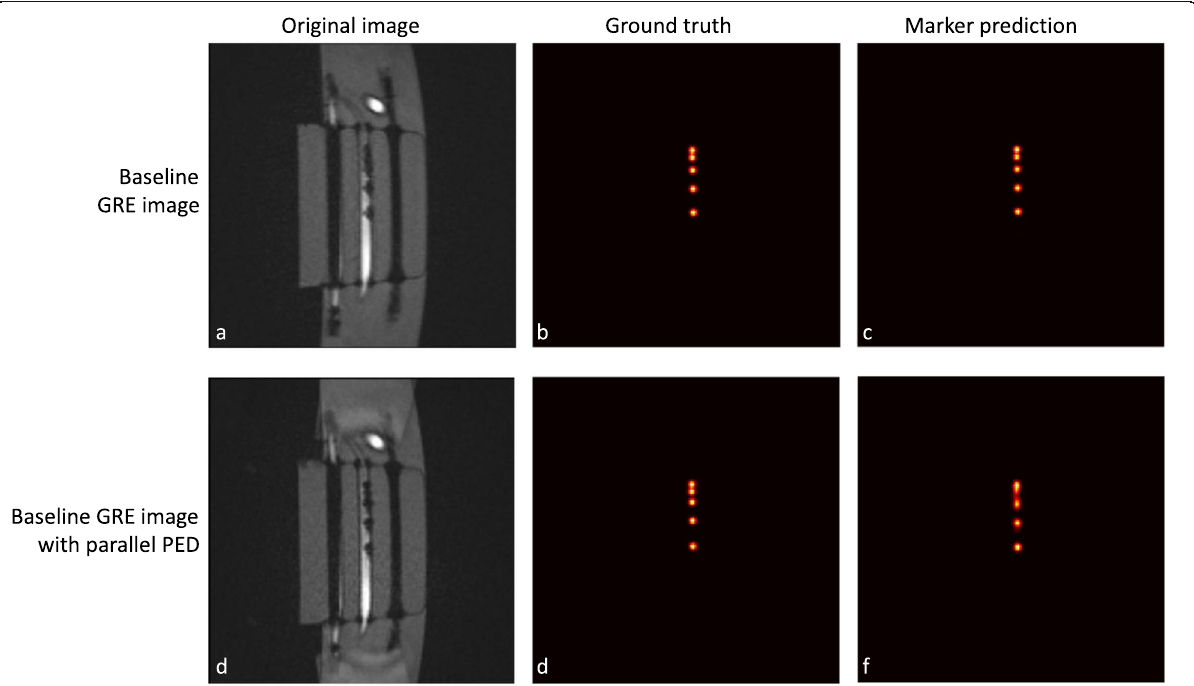
Fig. 7 Original baseline ( a ) and parallel phase encoding direction (PED) ( d ) gradient recalled echo images with corresponding ground-truth annotations ( b ) and ( e ), respectively. Probability maps generated by the deep learning model of the original and parallel PED image ( c , f ), respectively. Note that the marker prediction of the top three markers is less distinct for the parallel PED image compared to the baseline image